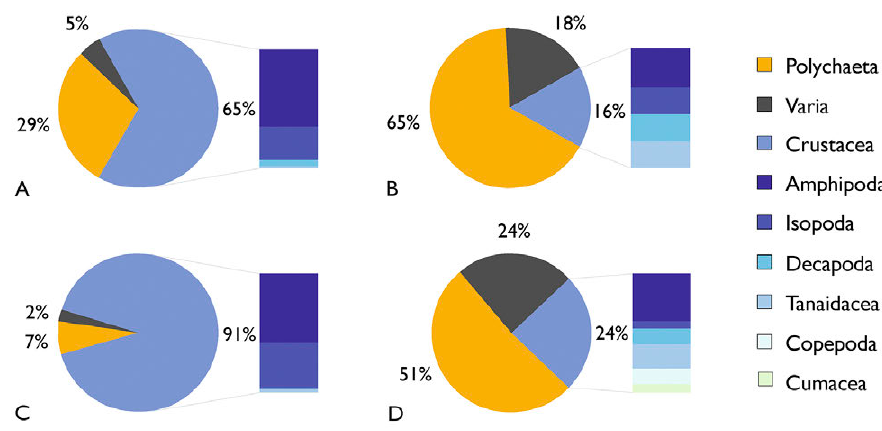
Fig. 2. – Taxonomic composition of the associated fauna of the sponges Agelas oroides (A: abundance, B: number of taxa) and Aplysina aero- phoba (C: abundance, D: number of taxa). The group “Varia” includes Nemertea, Nematoda, Sipuncula, Mollusca, Echinodermata and Pisces. Table 3. – Spearman’s rank correlation coefficient ( ρ ) between the sponge volume and the abundance (N) and species number (S) of symbionts ( ** significance at the 0.01 level; * significance at the 0.05 level). Agelas oroides Aplysina aerophoba Both species N